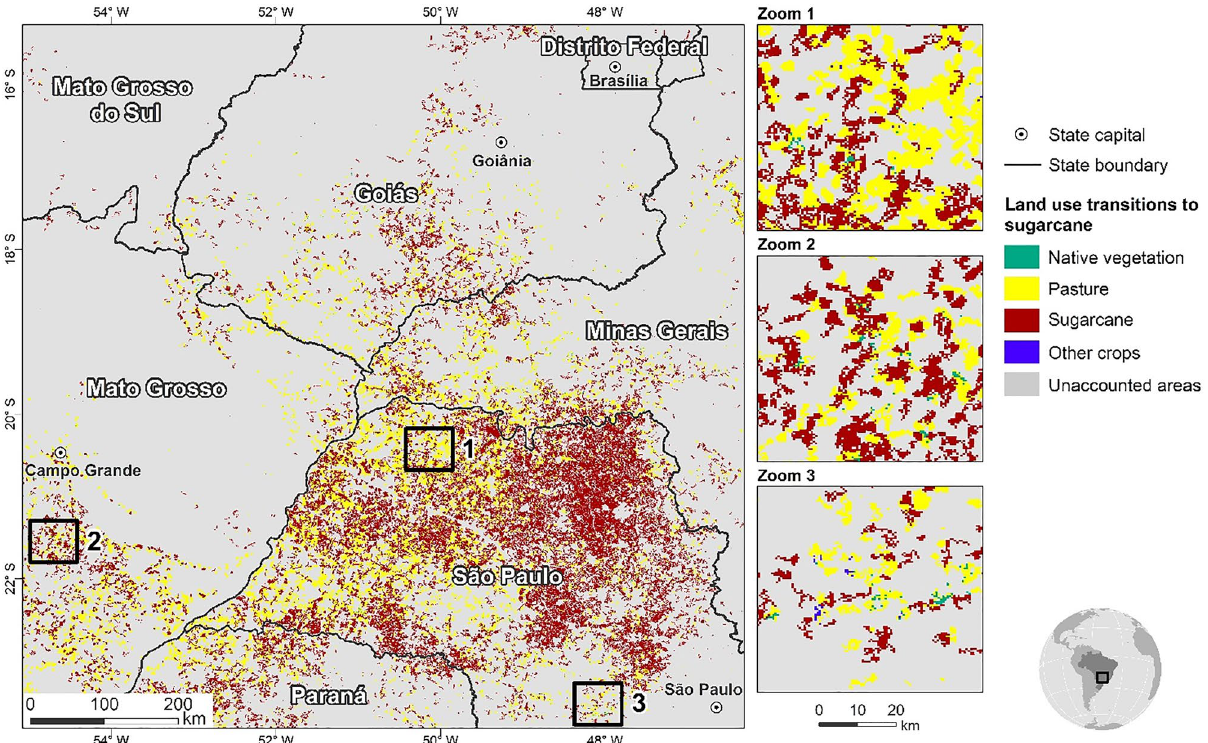
Figure 2. Land use transitions to sugarcane from 2019 to 2030. The vast majority of sugarcane expansion occurs onto pasturelands in the Southeast and Midwest of Brazil. Map created using Dinamica EGO 5 (https:// dinam icaego.